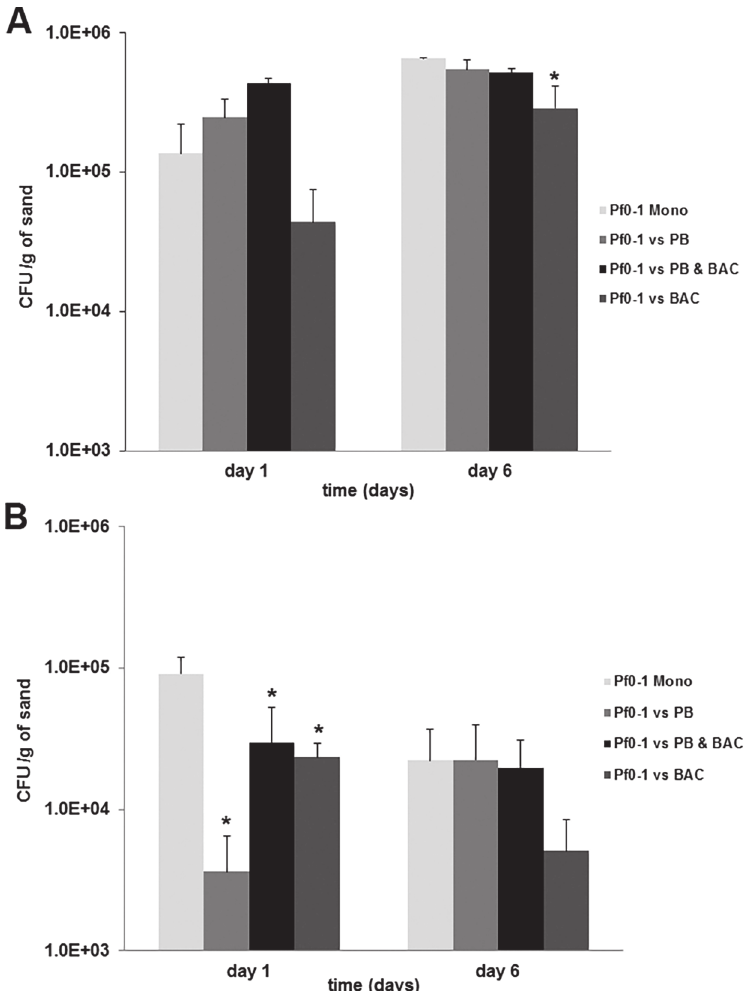
mixed cultures are indicated with an asterisk (p (cid:3) 0.05). Error bars are indicating standard deviation (SD) between the triplicates. Abbreviations: Pf0-1: Pseudomonas fluorescens Pf0-1, PB: Pedobacter sp. V48, BAC: Bacillus sp.